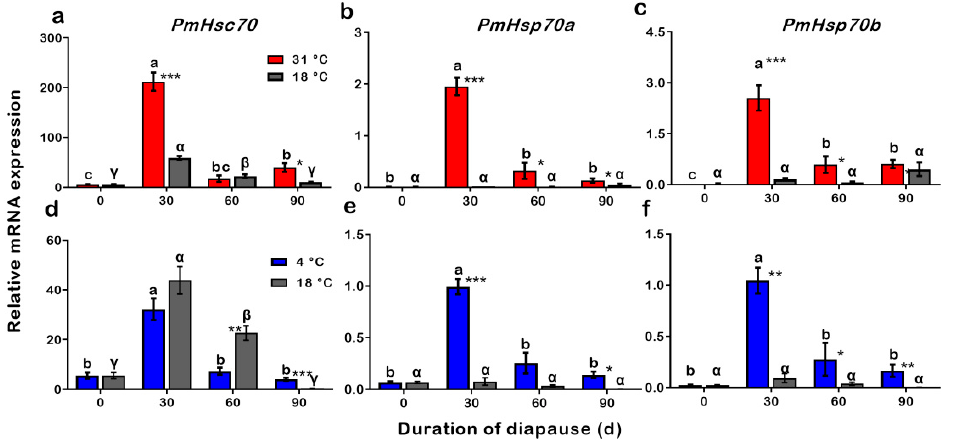
Figure 7. Relative expression analysis of PmHsc70 , PmHsp70a , and PmHsp70b mRNA transcription levels in SD ( a – c ) and WD ( d – f ) pupae that were incubated at different temperatures during diapause development. The relative expression levels (Mean ± SE) are normalized to β -actin and 18S rRNA. Different letters or Greek alphabet ( α , β , γ ) above the bar indicate significant differences by ANOVA and post hoc Bonferroni multiple comparison test ( p < 0.05) during diapause development at each temperature. The significant differences between 31 °C (SD), 4 °C (WD), and 18 °C (control) treatments are represented with an asterisk *. * p < 0.05, ** p < 0.01, and *** p < 0.001.